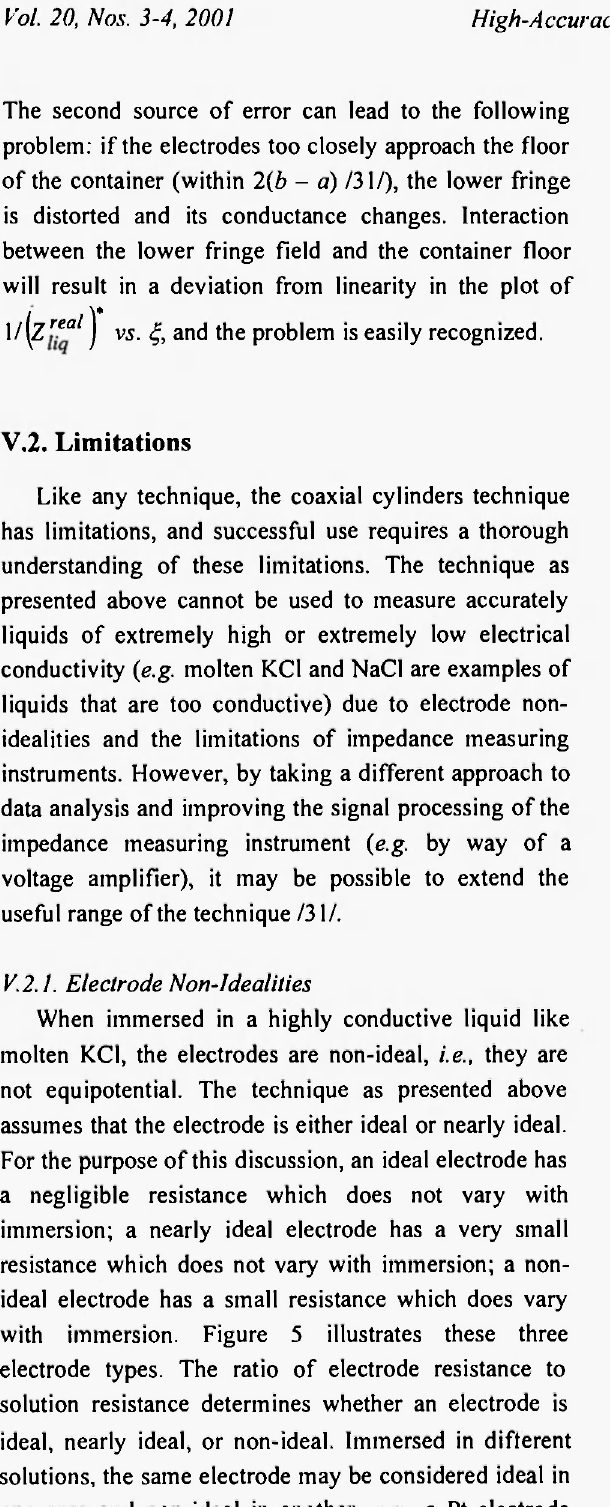
Fig. 5: Equivalent circuits of ideal, nearly ideal, and non-ideal electrodes at 3